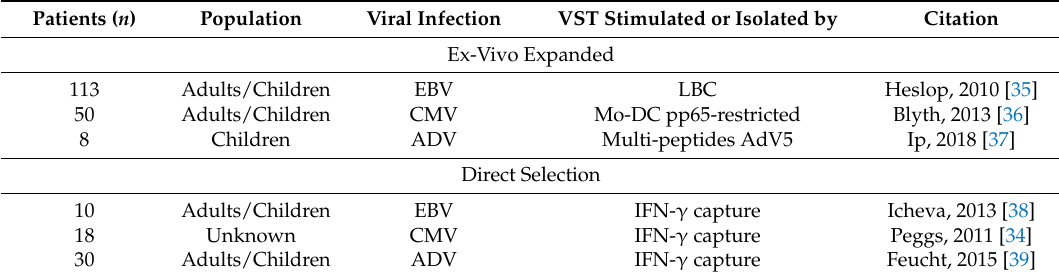
Table 2. Largest published clinical trials for treatment and prevention of viral reactivation after HSCT using donor-derived single-virus adaptive therapy, using either ex vivo expansion or direct